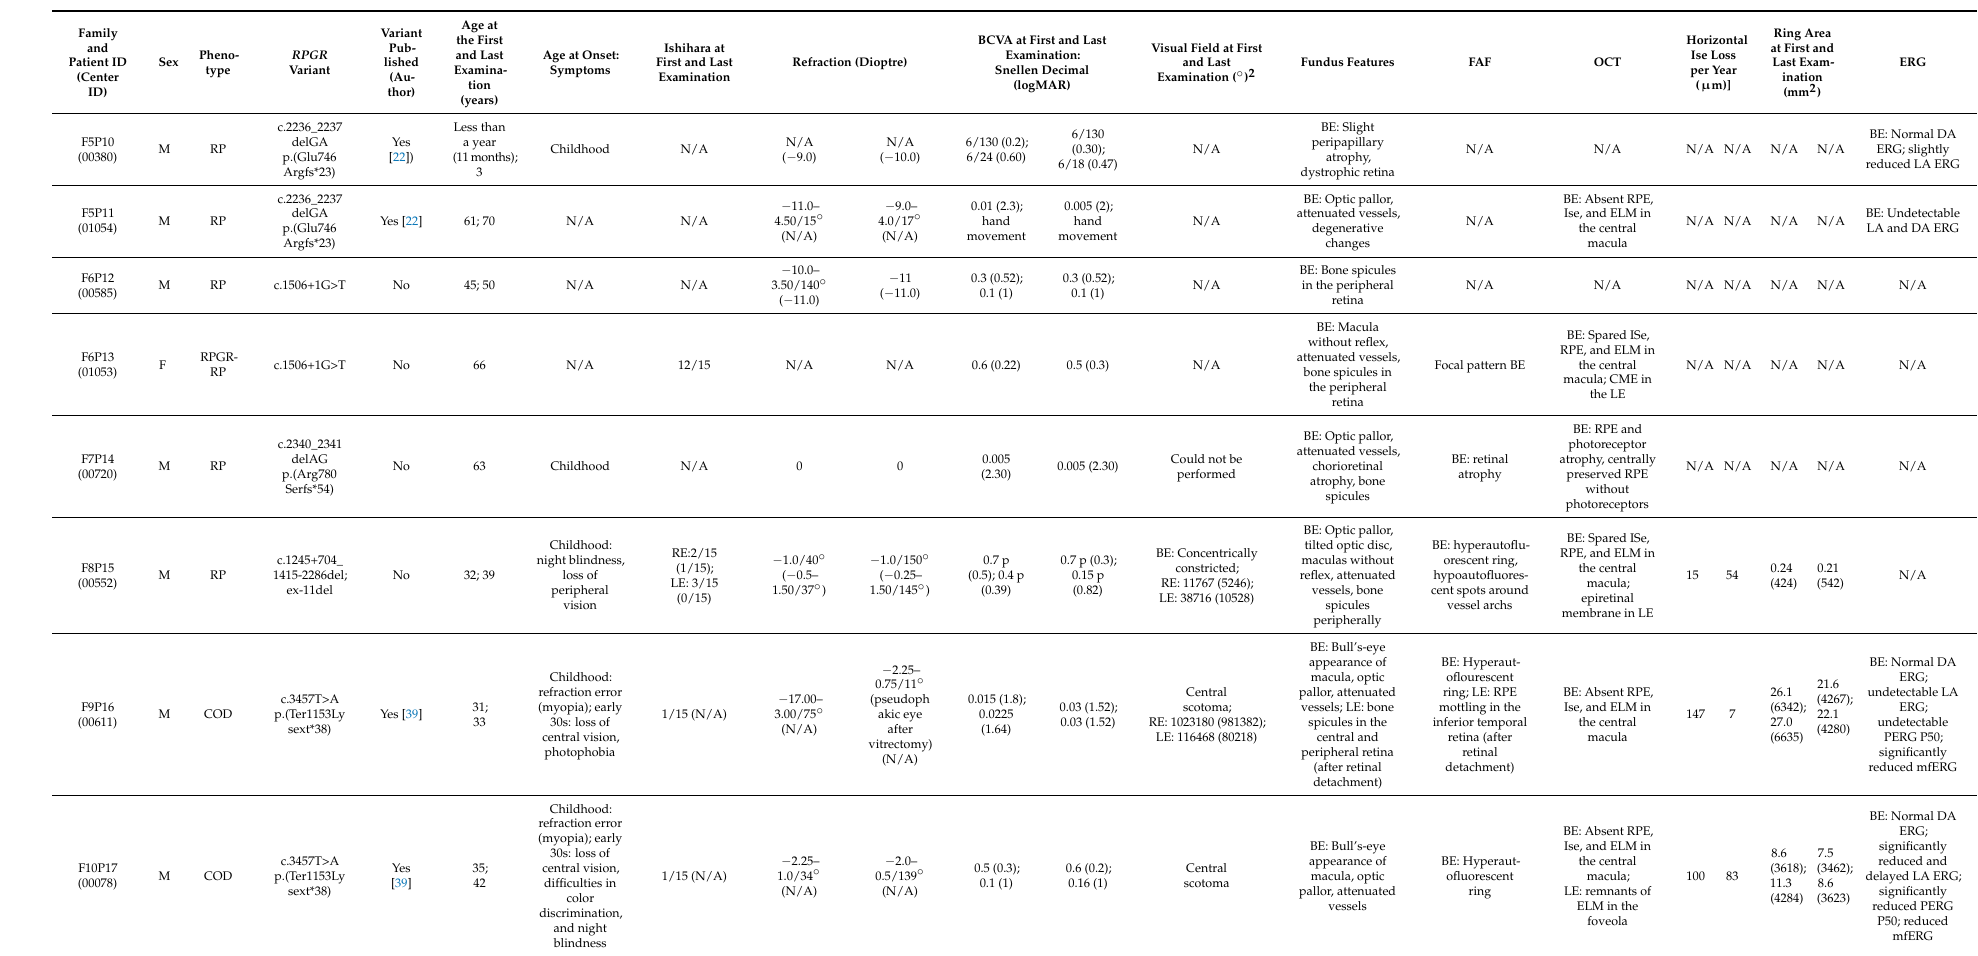
Central scotoma